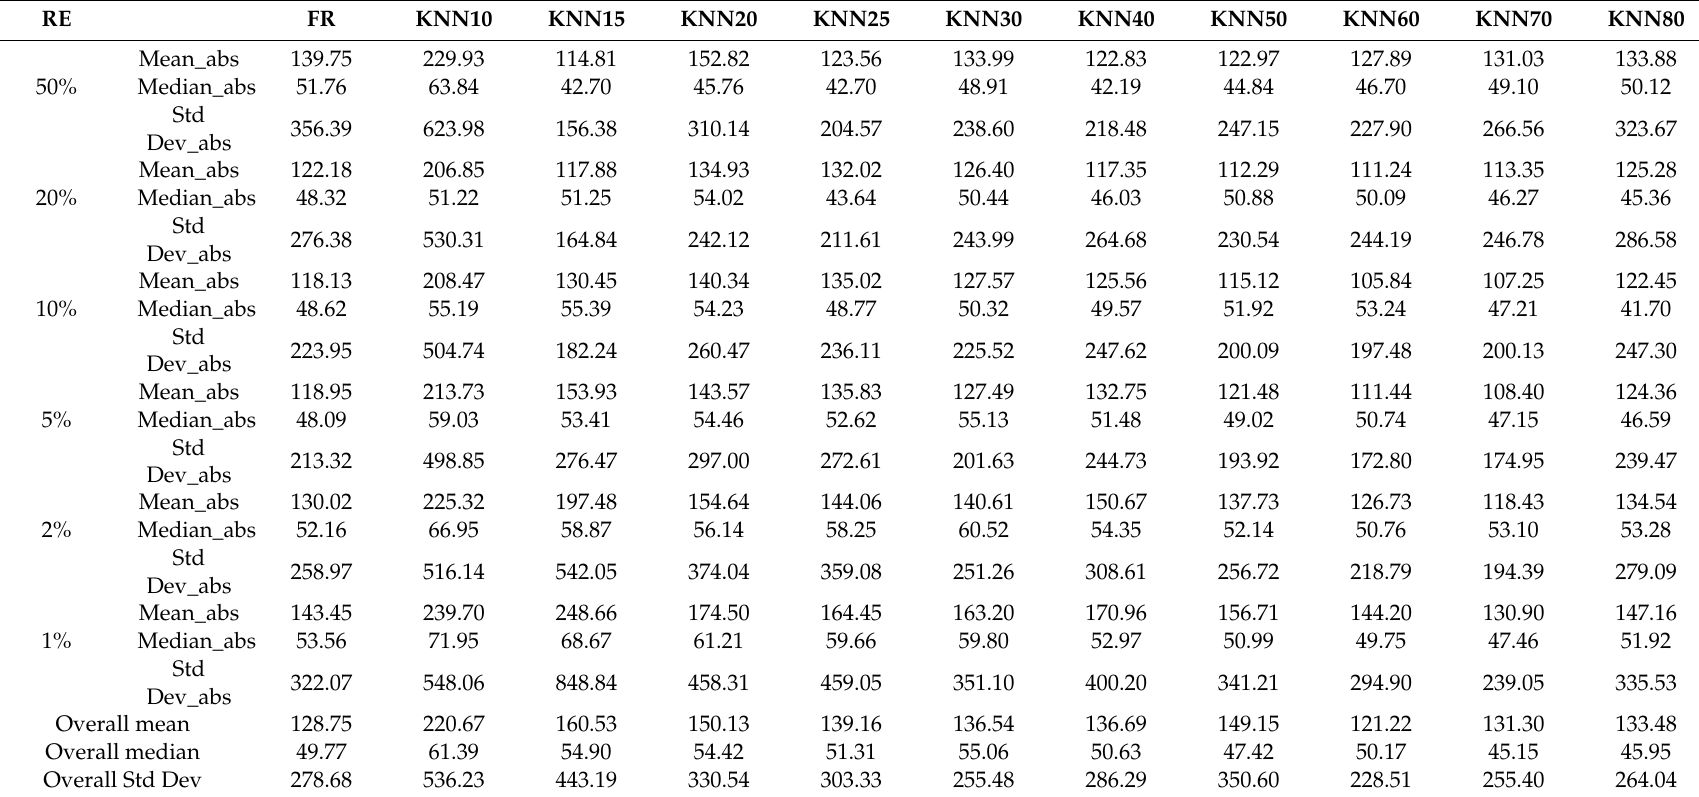
Table 5. Mean, median and standard deviation of relative error for fixed region (FR) and